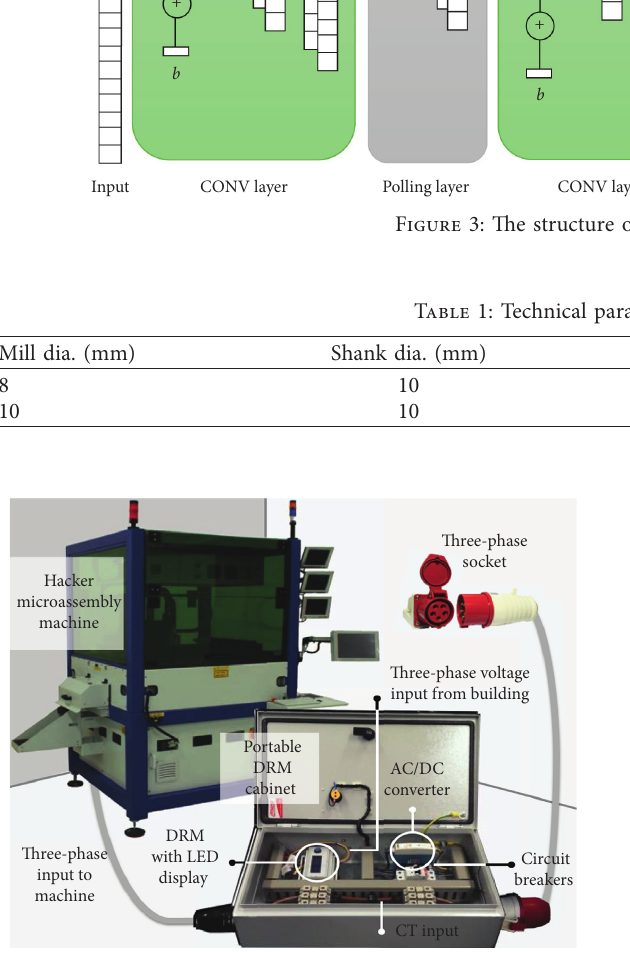
Figure 4: Illustration of test